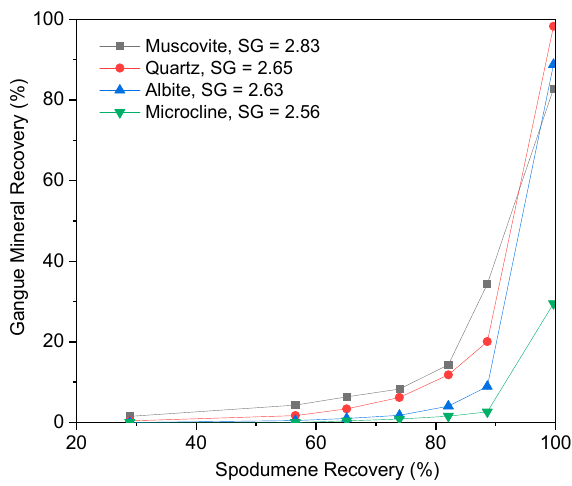
Figure 6. Heavy mineral distribution (wt. %) of sink fraction for different S.G. cut points.